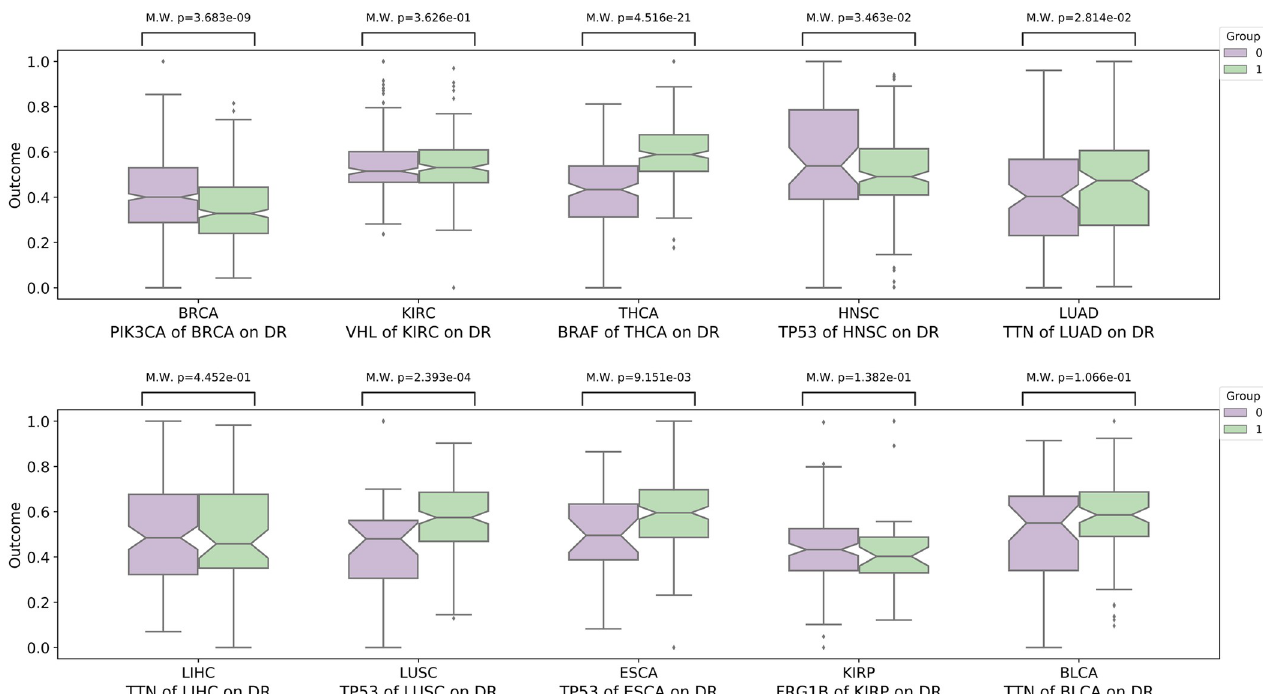
Fig 7. The Mann-Whitney U test (M.W.) analysis shows there is no significant differences between mutated groups and non-mutated groups of mutated genes with high mutation rates in the activity of DNA replication (DR) for 10